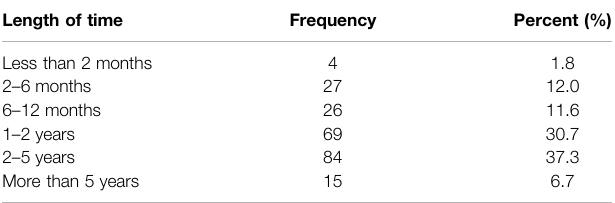
TABLE 1 | Duration spent in Australia as an international